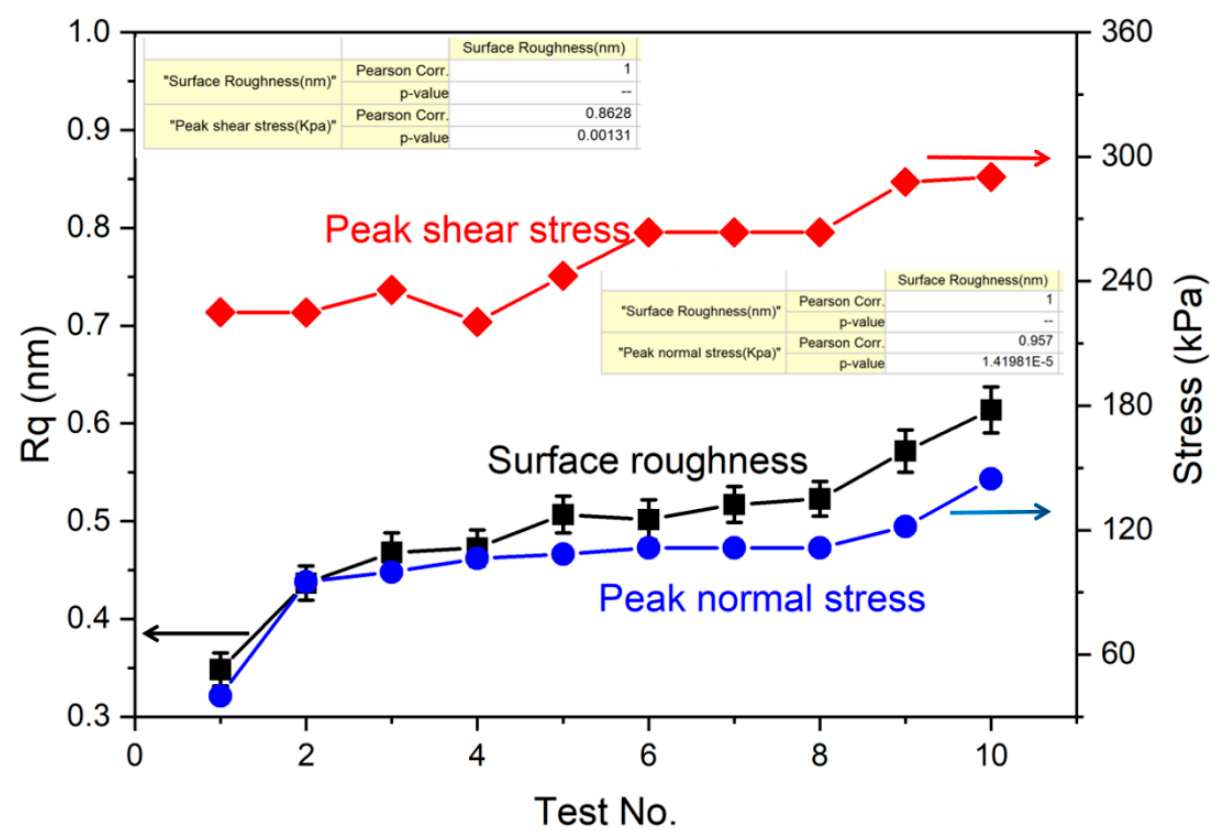
Figure 4. Comparison of the stresses and surface roughness (Rq) in 10 rounds of the MRF experiments.